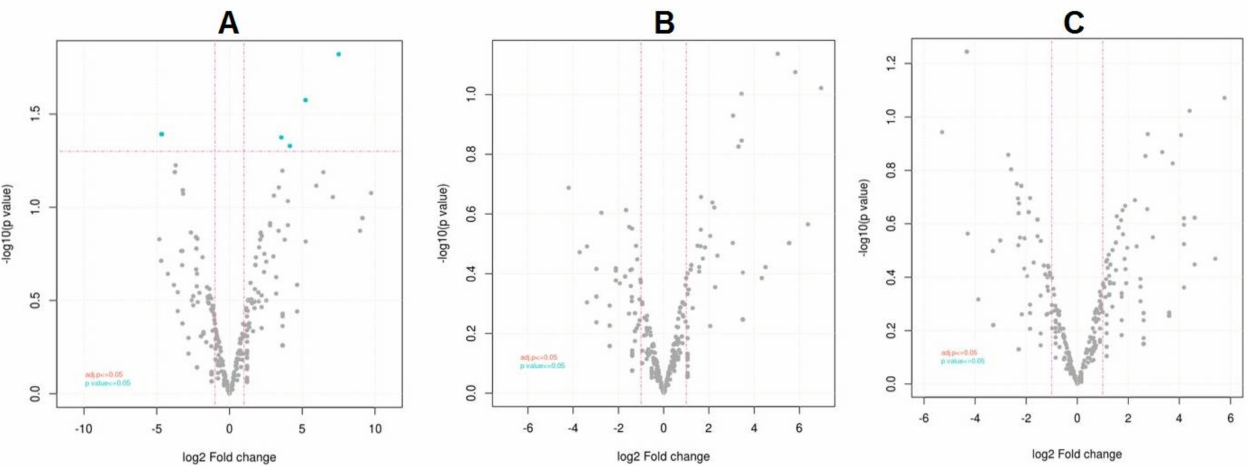
Figure 2. Volcano plot showing differential expression level of miRNAs. ( A ) Volcano plot for SDW-control vs. pathogen- infected plants, ( B ) SDW-control vs. TriH_JSB36-treated plants, ( C ) TriH_JSB36-treated vs. pathogen-infected plants.